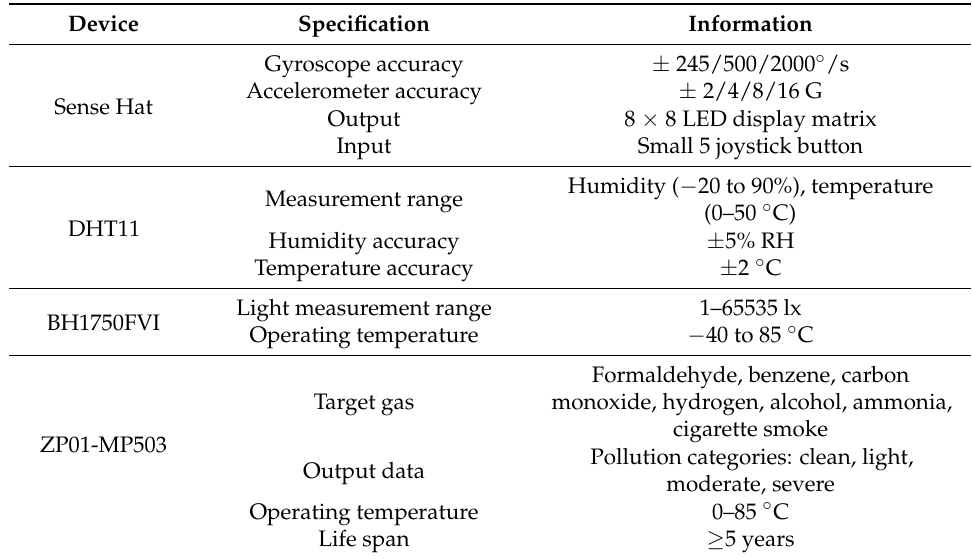
Table 1. Proposed affordable fast early warning system (AFEWS) sensor